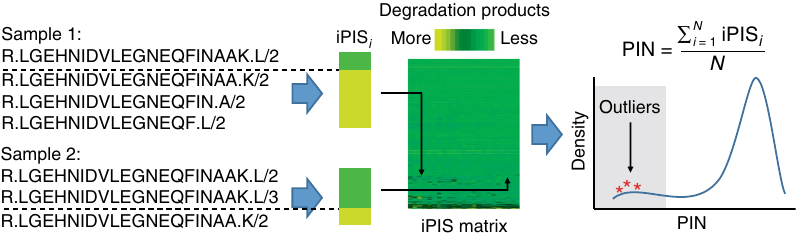
Fig. 1 The PIN algorithm. Shown is a schematic diagram of the computational work